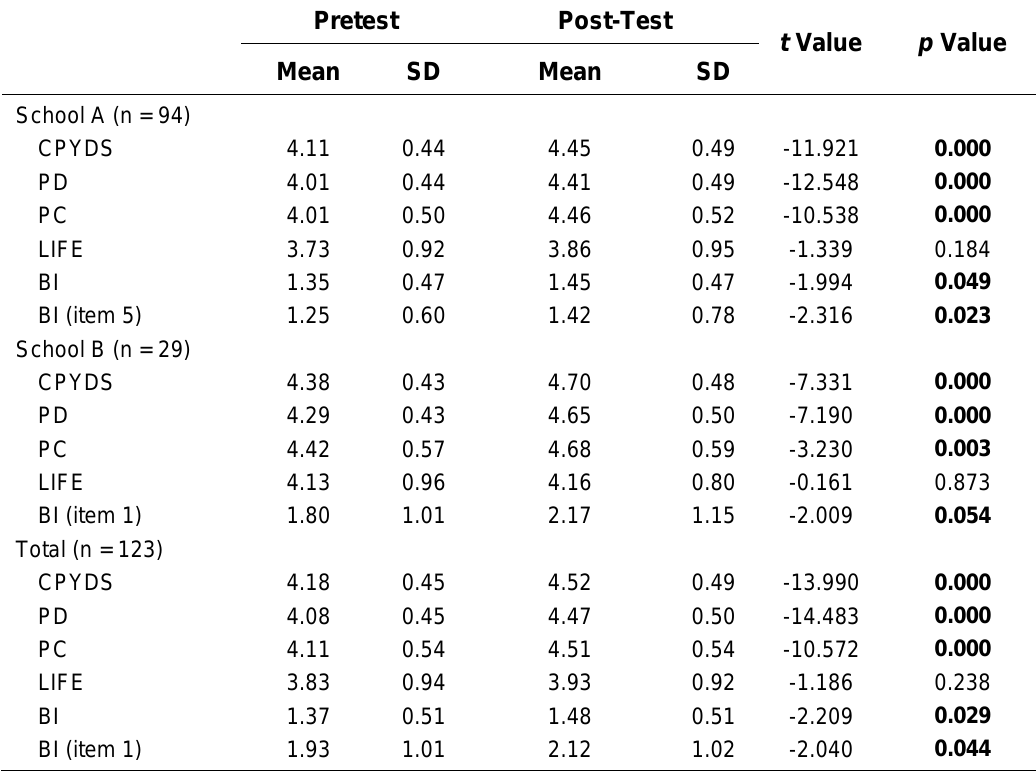
Participants having Positive Changes on the CPYDS